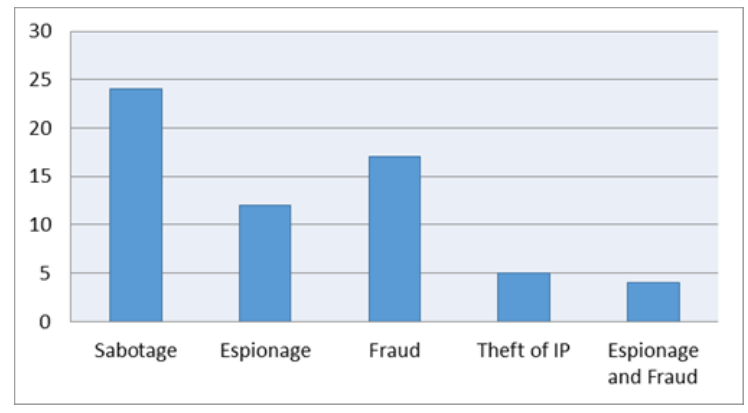
Figure 6. Insider profiling.